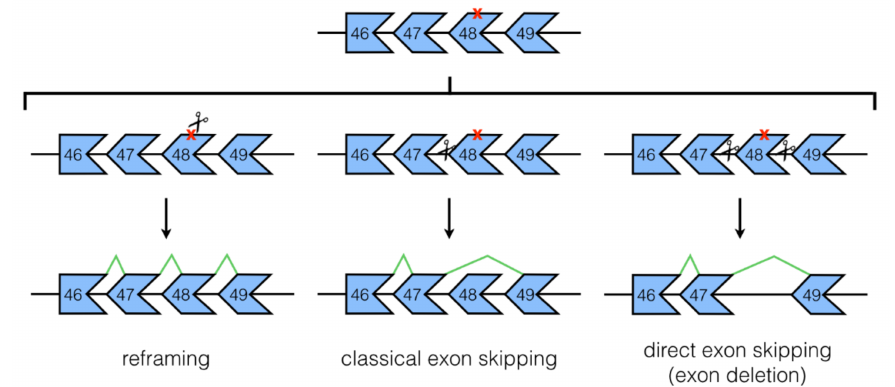
Figure 1. Mechanisms of non-homologous end joining (NHEJ) mediated gene correction by CRISPR/Cas9. On the top is shown a stretch of the DMD gene from a hypothetical patient with a point mutation in exon 48 (marked by an X) that creates a premature stop codon. CRISPR/Cas9, through NHEJ repair, can correct this genetic defect in one of three ways: reframing, classical exon skipping, or direct exon skipping. These approaches differ depending on which site is targeted by the gRNA (represented by scissors), as well as by the number of gRNAs used for treatment. Boxes represent exons; lines between boxes represent